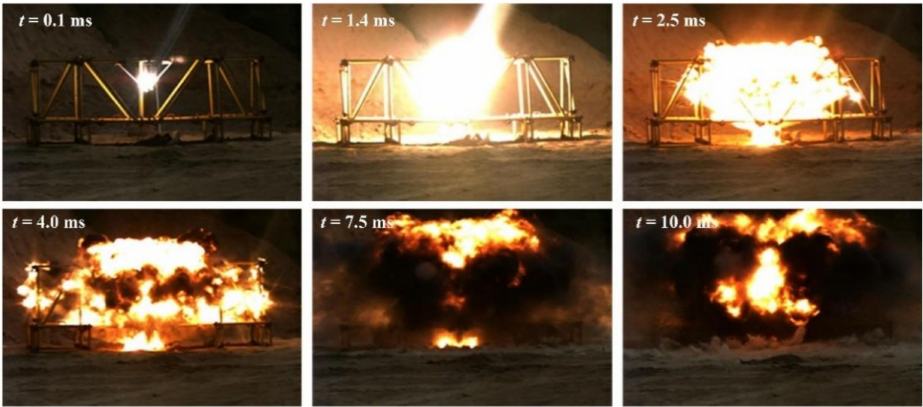
Figure 6. The explosion process with a certain explosion height.